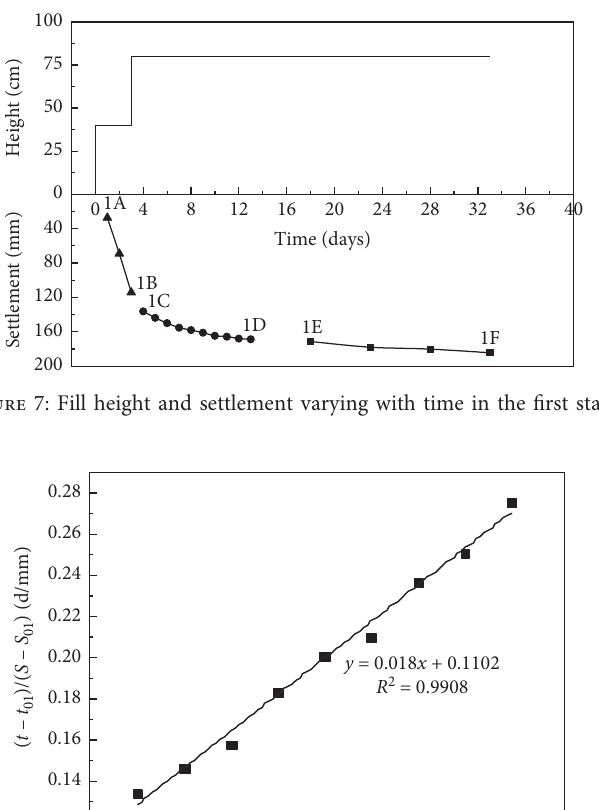
) / ( S − S ) and ( t − t t 01 01